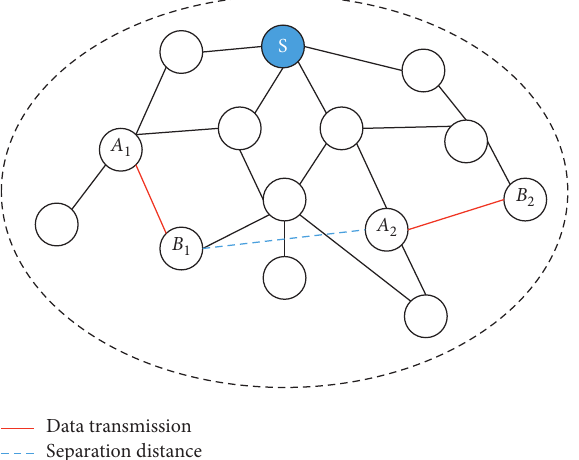
Figure 2: The schematic diagram that I